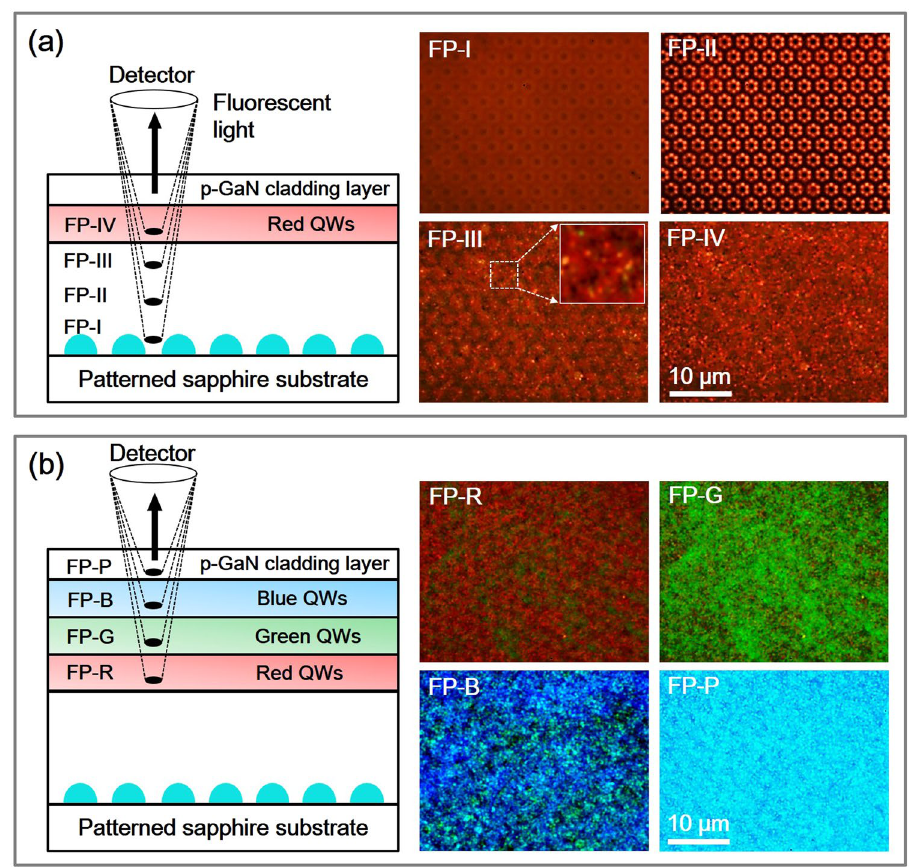
Figure 4. ( a ) Schematic diagram of the four different FPs positioned in the vertical direction of the RLED for FM measurements and the FM images obtained from the FPs of FP-I, FP-II, FP-III (the inset is a magnified view), and FP-IV. ( b ) Schematic diagram of the four different FPs positioned in the vertical direction of the WLED and the FM images obtained from the FPs of FP-R, FP-G, FP-B, and